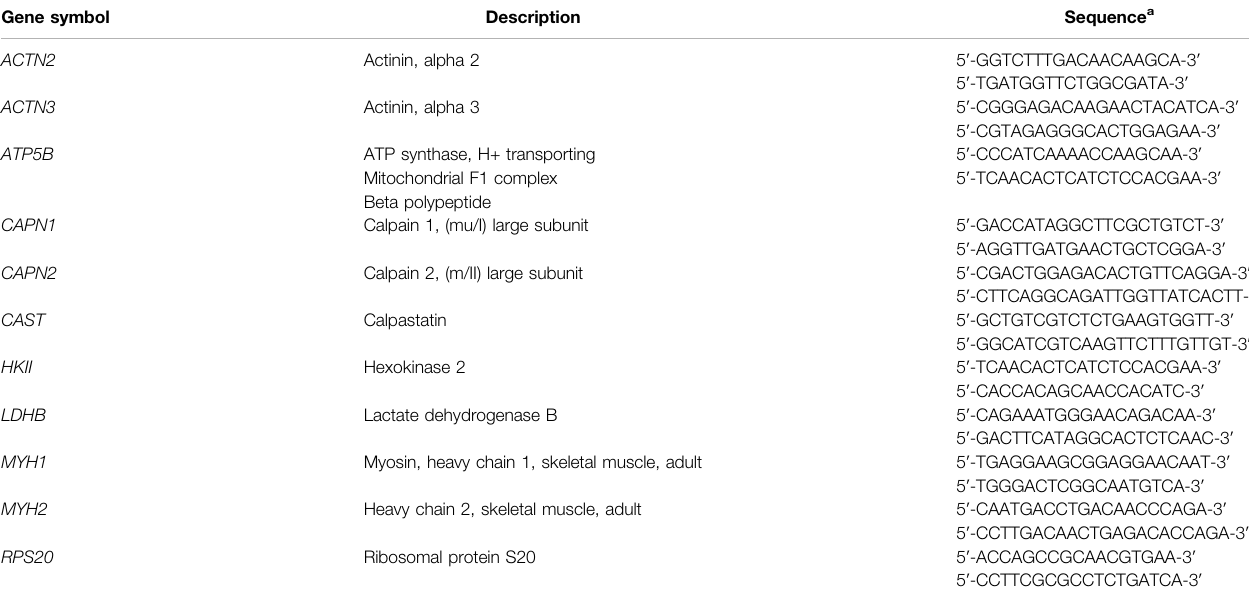
TABLE 5 | Complete list of primer pairs used for qRT-PCR assays and their function in muscle.